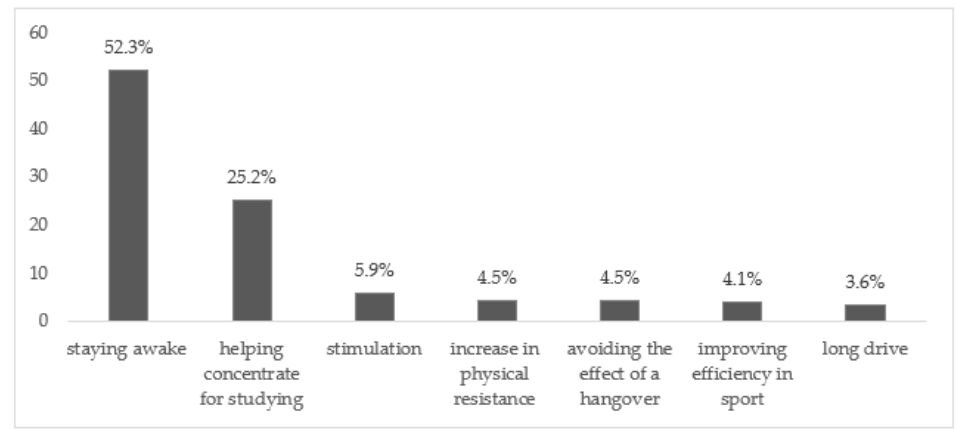
Figure 1. The main reasons for EDs consumption among the student population in Eastern Croa- tia.